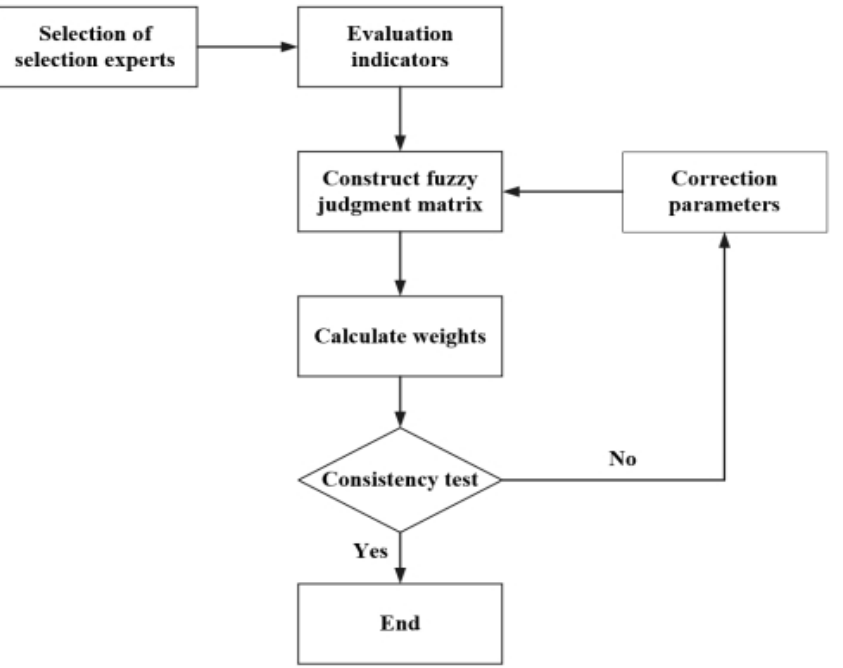
Figure 2. The multiple steps involved in conducting the intuitionistic fuzzy analysis.